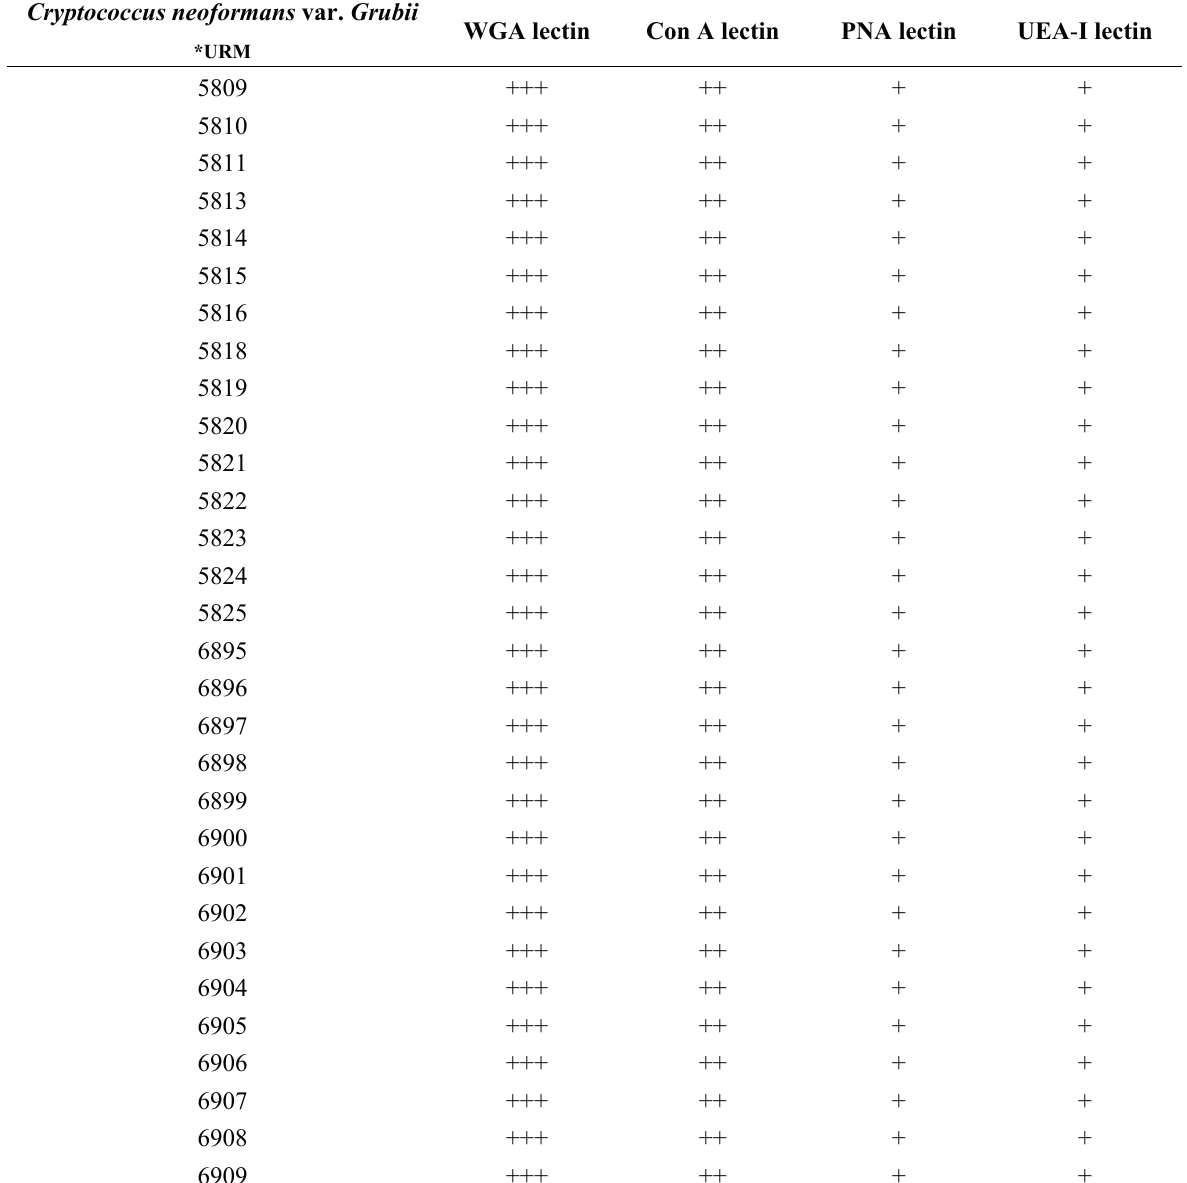
Table 1. Cryptococcus neoformans var. grubii strains and fluorescence patterns of lectin staining. Cryptococcus neoformans var.